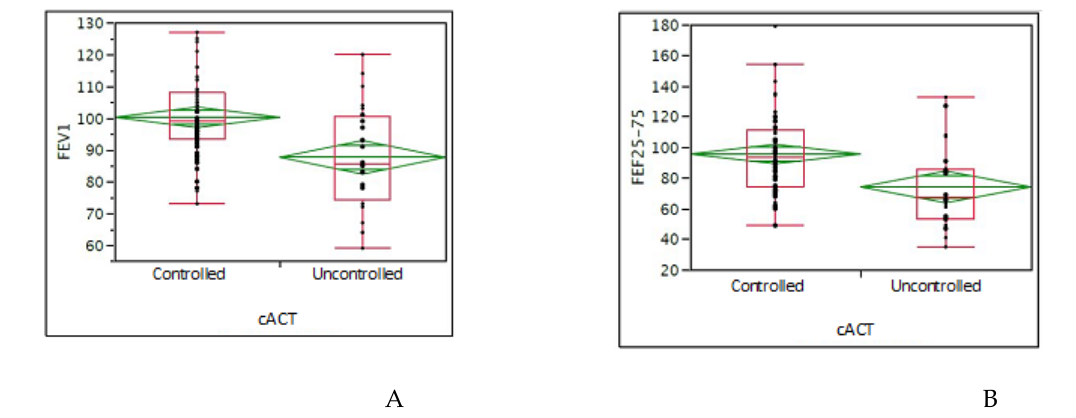
Figure 2. ( A ): comparison of FEV 1 values between controlled and uncontrolled asthmatic children evaluated by cACT; ( B ): comparison of FEF 25-75 values between controlled and uncontrolled asthmatic children evaluated by cACT (Asthma Control Test in children). Data are expressed as medians and interquartile ranges. The T-test was